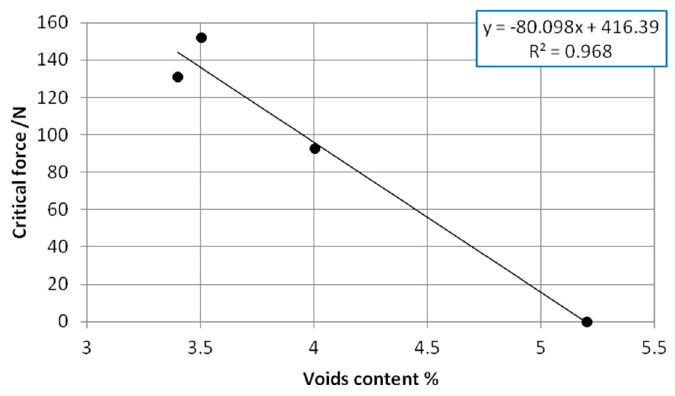
Appl. Sci. 2019 , 9 , x FOR PEER REVIEW Figure 14. Relationship between the critical force and voids content. Figure 14. Relationship between the critical force and voids content.